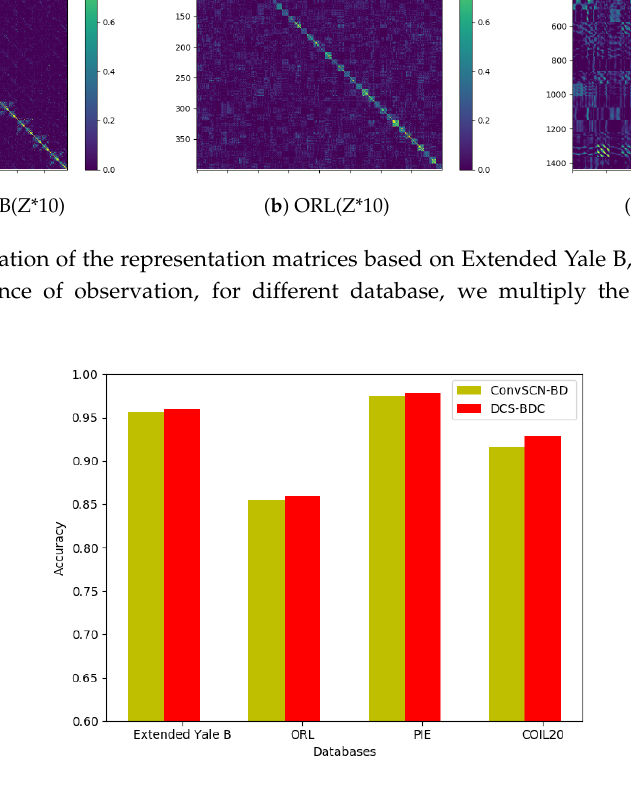
Figure 3. The accuracy comparison of the method using the separation strategy (DSC-BDC) and the method without the separation strategy